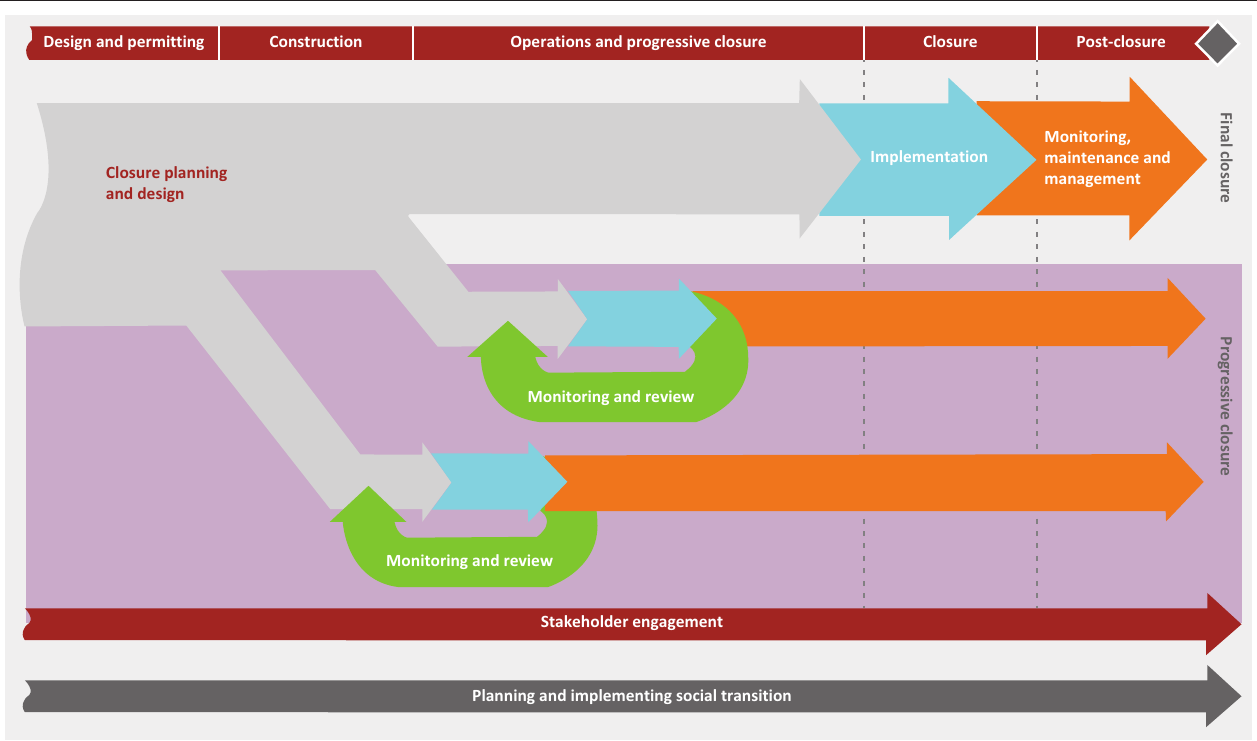
FIGURE 4: Integrated mine closure good practice. 22